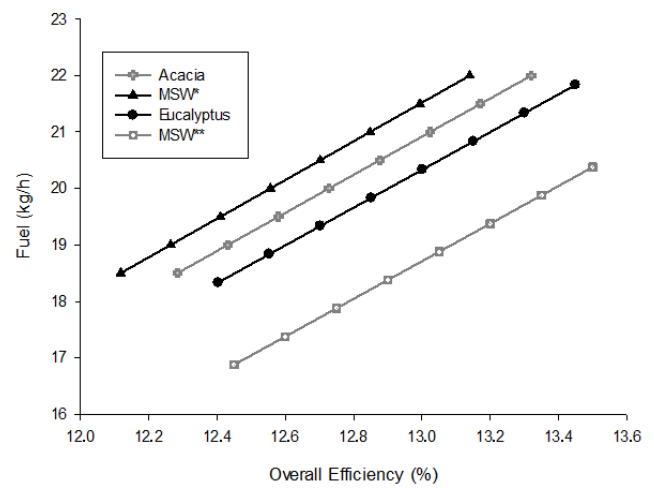
Figure 6. Sankey diagram of the gasification system-ICEG for: ( a ) acacia, ( b ) MSW *, ( c ) eucalyptus and ( d ) MSW **.